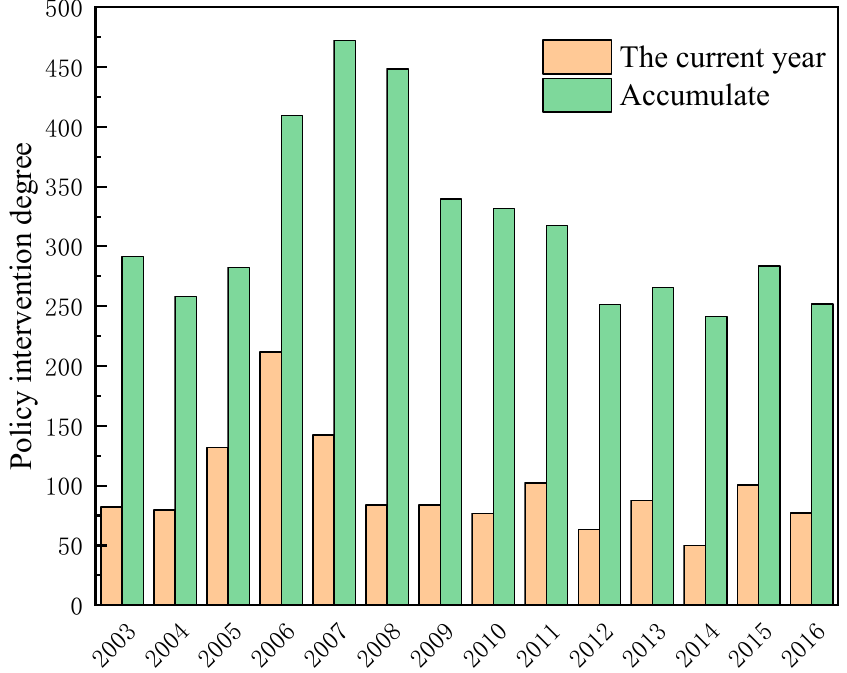
Figure 18. Histogram of the intervention degree of China’s gas control policy from 2003 to 2016.